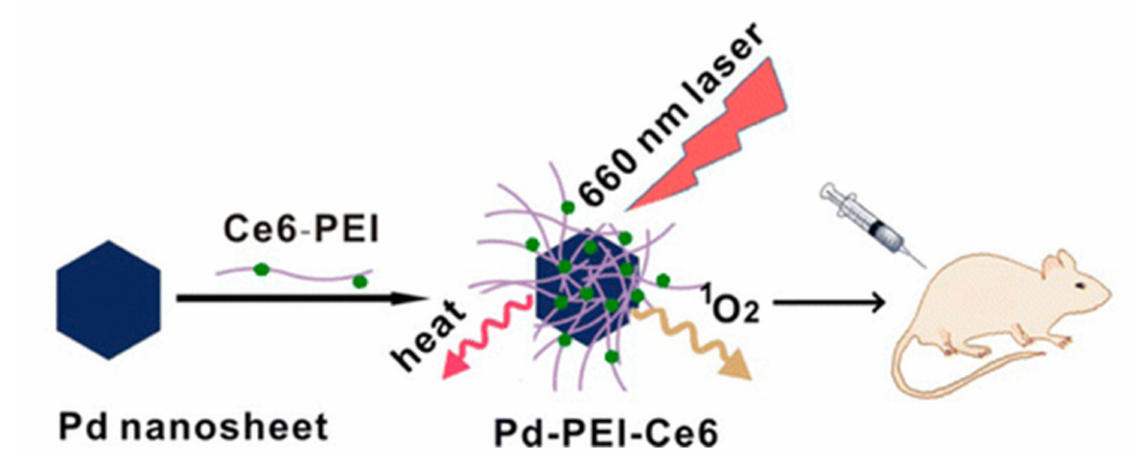
Figure 15. Palladium (Pd) nanosheet composite materials used in photothermal therapy. Reprinted with permission from Ref. [160]. Copyright 2014 American Chemical